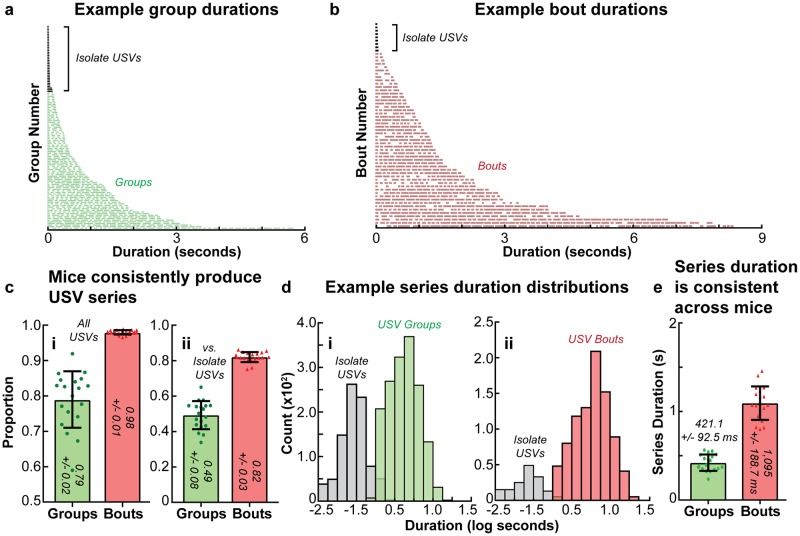
USV series production is consistent across mice.Example (a) group and (b) bout durations in a single recording session of an adult mouse, with isolate USVs indicated. Series and isolate USVs are stacked according to duration, with the shortest on top and the start of the vocal unit on the left. Each individual line represents a USV and white spaces between lines represent ISIs, with the size of the lines and white spaces representing to scale the duration of the USVs and ISIs, respectively. The mean proportion of (ci) of USVs produced in groups and bouts, and (cii) groups and bouts as opposed to isolate USVs. Additional statistical details are presented in S8 Table. Histograms of isolate USV and (di) group and (dii) bout duration from all recording sessions of one adult mouse; isolate USVs and USV series form distinct distributions. (e) Mean duration of groups and bouts across all 19 mice. Additional statistical details are presented in S9 Table. In (e), mean durations are transformed from log seconds to represent series duration with a more familiar measure. In (c) and (e), error bars indicate the mean across animals +/-1 standard deviation, and values for individual mice are represented by the 19 overlaid points.